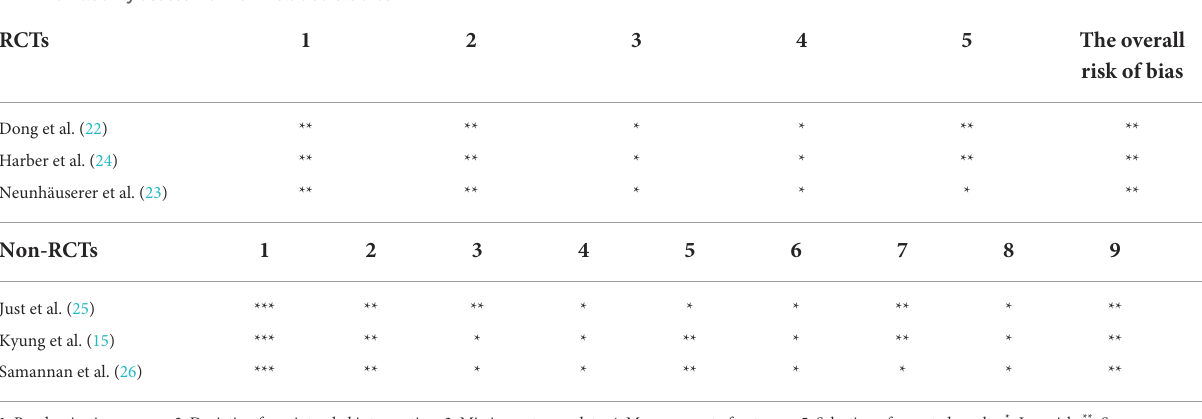
TABLE 3 Quality assessment of included studies. RCTs 1 2 The overall